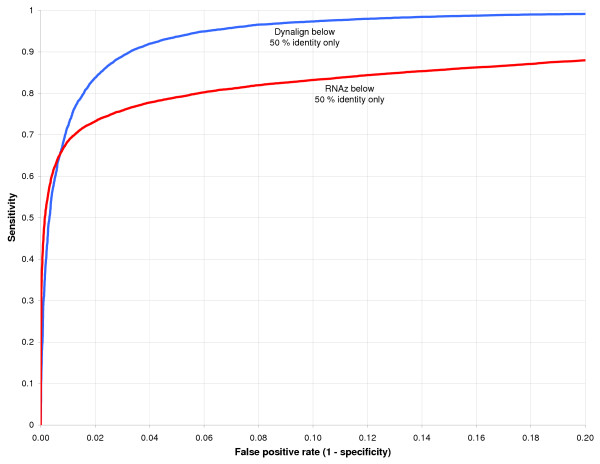
Comparison of the Dynalign/LIBSVM classifier with RNAz for sequence pairs below 50% identity. ROC curves for the Dynalign/LIBSVM classifier method (blue) and RNAz (red), both tested only on those sequence pairs from the Figure 10 test set that have less than 50% sequence pair identity.